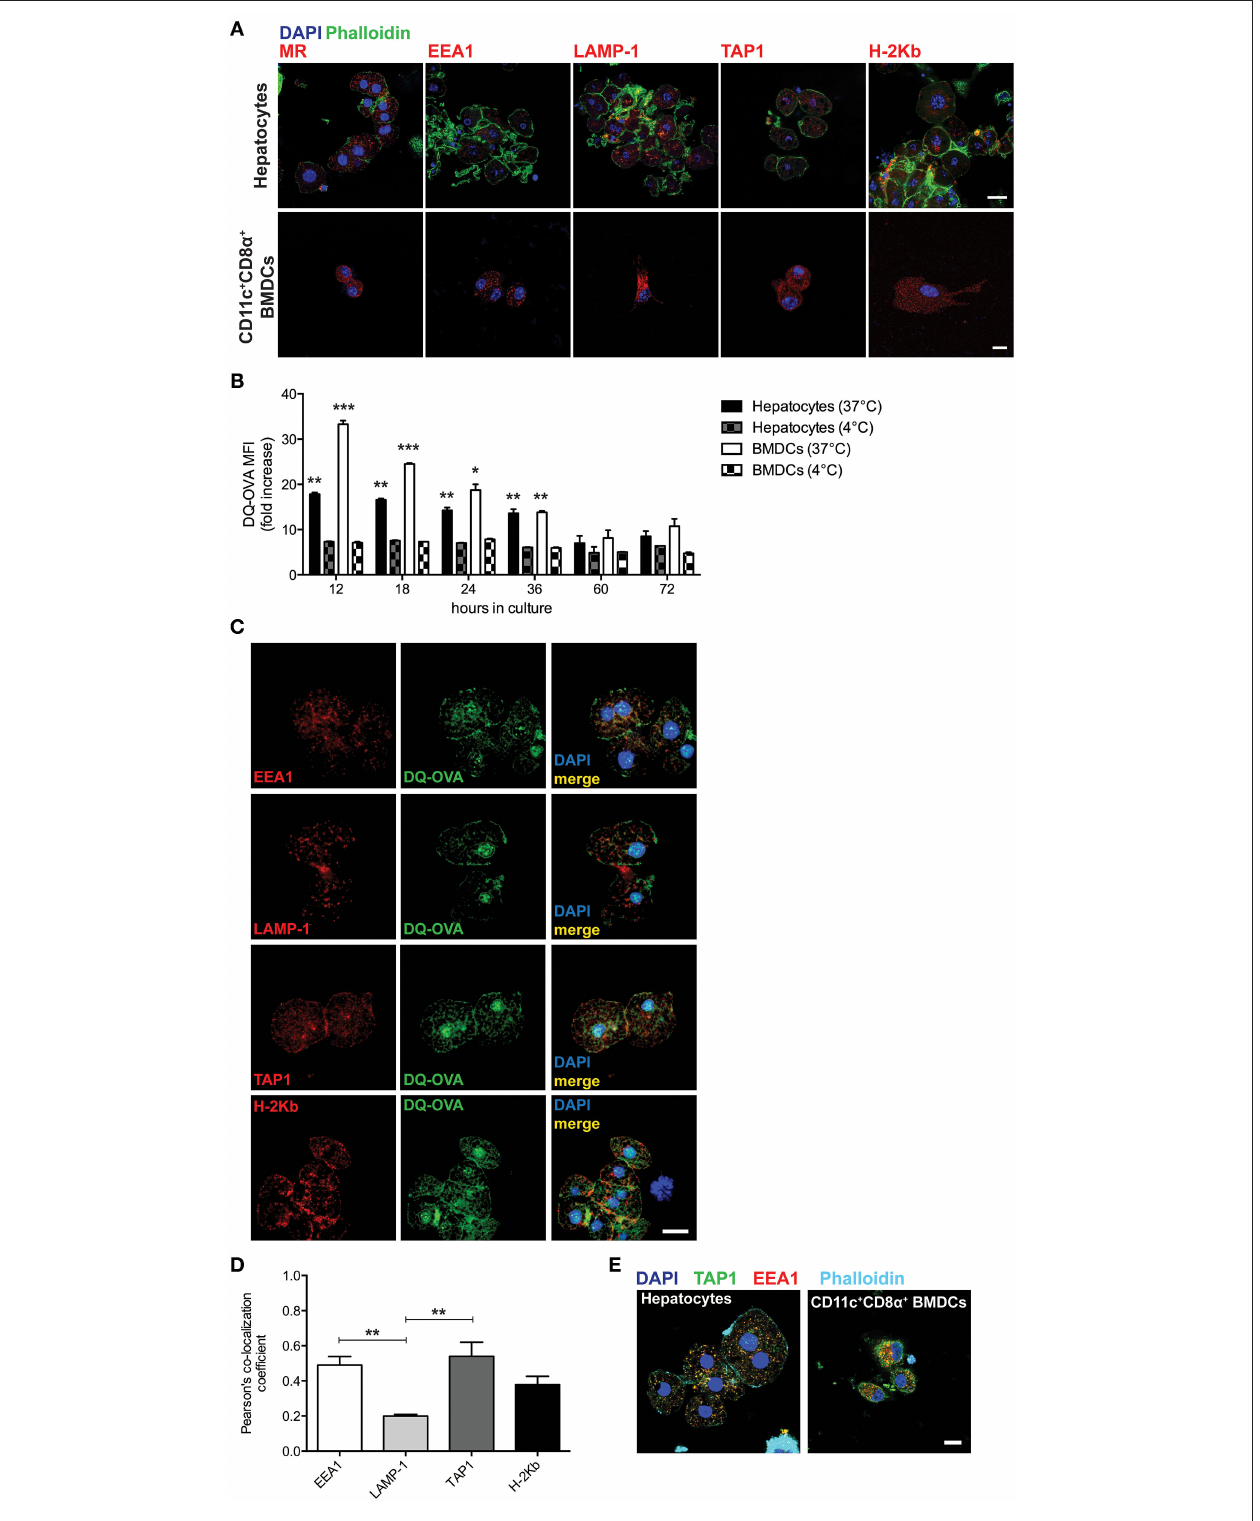
FIGURE 1 | Hepatocytes take up and process extracellular antigens in cross-presentation-competent phagosomes. (A) Primary hepatocytes isolated from C57BL/6 mice contain subcellular organelles staining positive for MR, EEA1, LAMP-1, TAP1, and H-2Kb, which are typically associated with antigen cross-presenting functions. Sorted CD11c + CD8 α + BMDCs from C57BL/6 mice were chosen as a positive control. Scale bar = 10 µ m. (B) The fluorescent signal originated from the intracellular